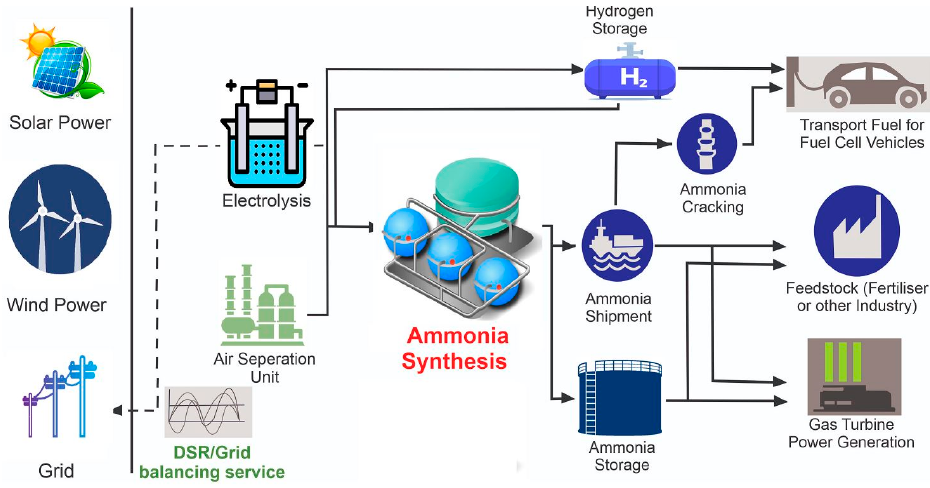
Figure 5. Schematic of renewable energy-driven Haber–Bosch plant [62].